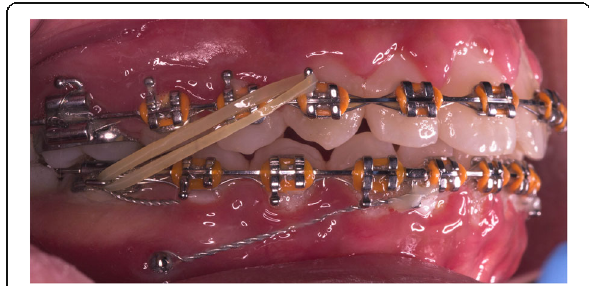
Fig. 2 Intra-oral lateral view with class II elastics (mini-implant group)